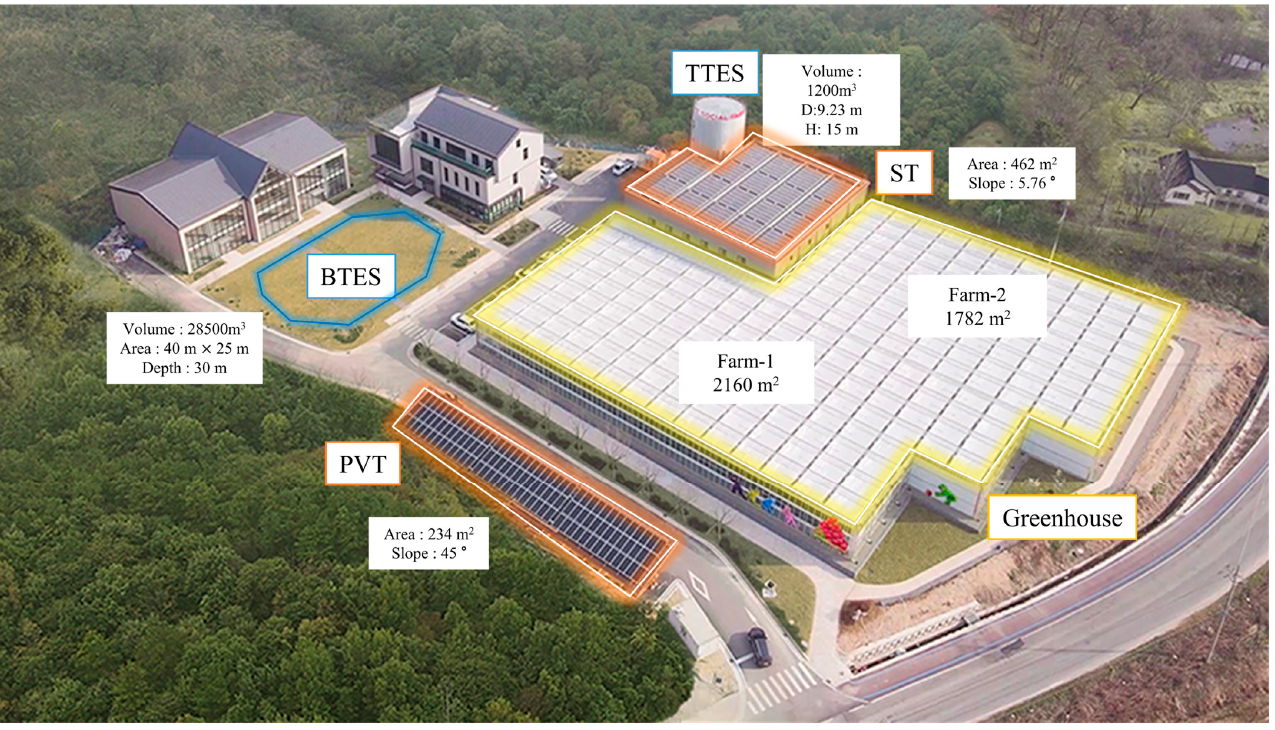
Figure 1. View of the test site.